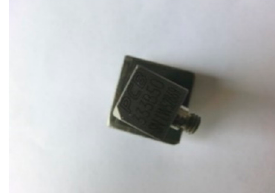
Figure 4. Acceleration sensor.